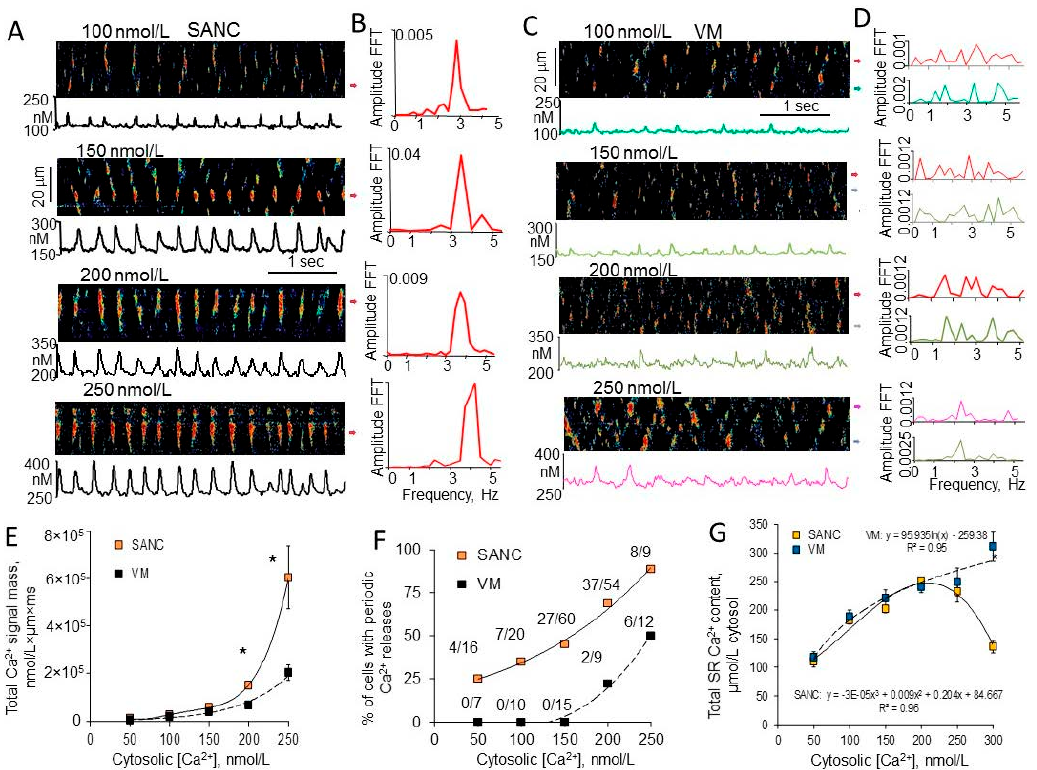
Figure 2. Spontaneous local Ca 2+ releases are more robust and periodic in permeabilized rabbit SANC than in ventricular myocytes (VM). ( A , C ) Confocal images, Ca 2+ waveforms; and ( B , D ) fast Fourier transform (FFT) of Ca 2+ waveforms showed more rhythmic and large Ca 2+ releases in saponin-permeabilized rabbit SANC than in ventricular myocytes bathed at the same cytosolic free [Ca 2+ ] f (modified from Sirenko et al. [35]). ( E ) Total amount of Ca 2+ released from the SR (total Ca 2+ signal mass) was comparable between SANC and ventricular myocytes at 50–100 nmol/L [Ca 2+ ] f and significantly higher in SANC than in ventricular myocytes at [Ca 2+ ] f > 150 nmol/L. ( F ) Relative number of cells generated periodic spontaneous Ca 2+ releases was higher in SANC than that in ventricular myocytes at the same [Ca 2+ ] f . ( G ) SR Ca 2+ content was comparable in saponin-permeabilized SANC and VM at physiological Ca 2+ concentration (50–250 nmol/L), and significantly higher in VM than in SANC at 300 nmol/L [Ca 2+ ] f . *Indicates statistical significance ( p < 0.05).